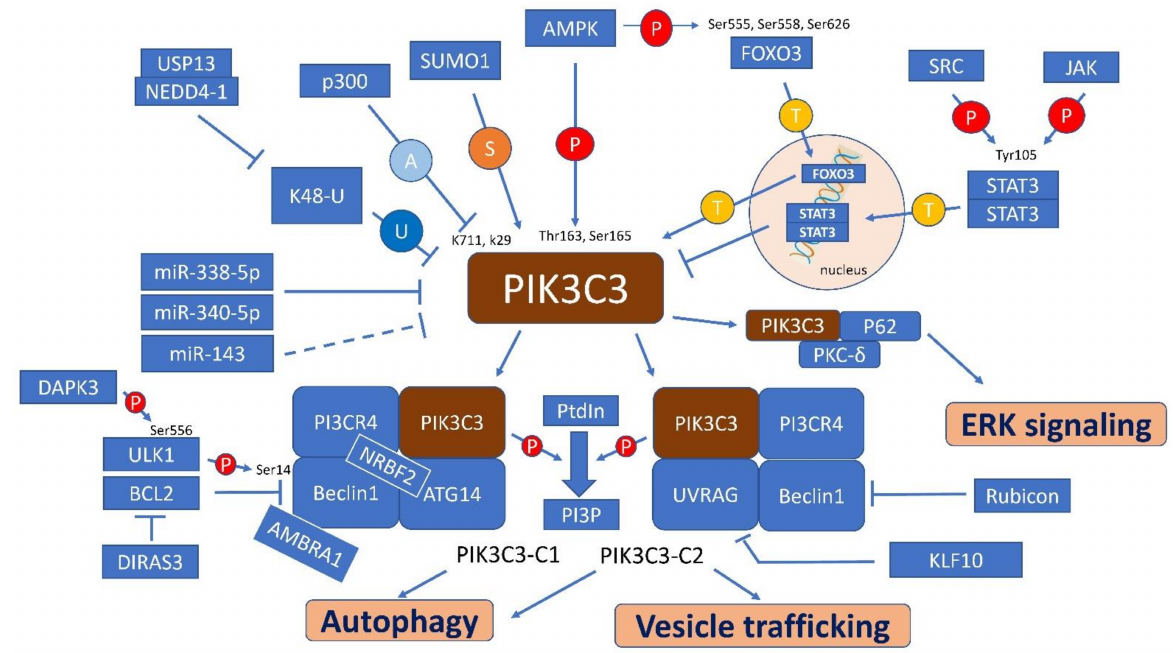
Figure 2. PIK3C3 related pathway in mammals. P: phosphorylation; A: acetylation; T: nuclear entry and regulation by transcription; U: ubiquitination; S: